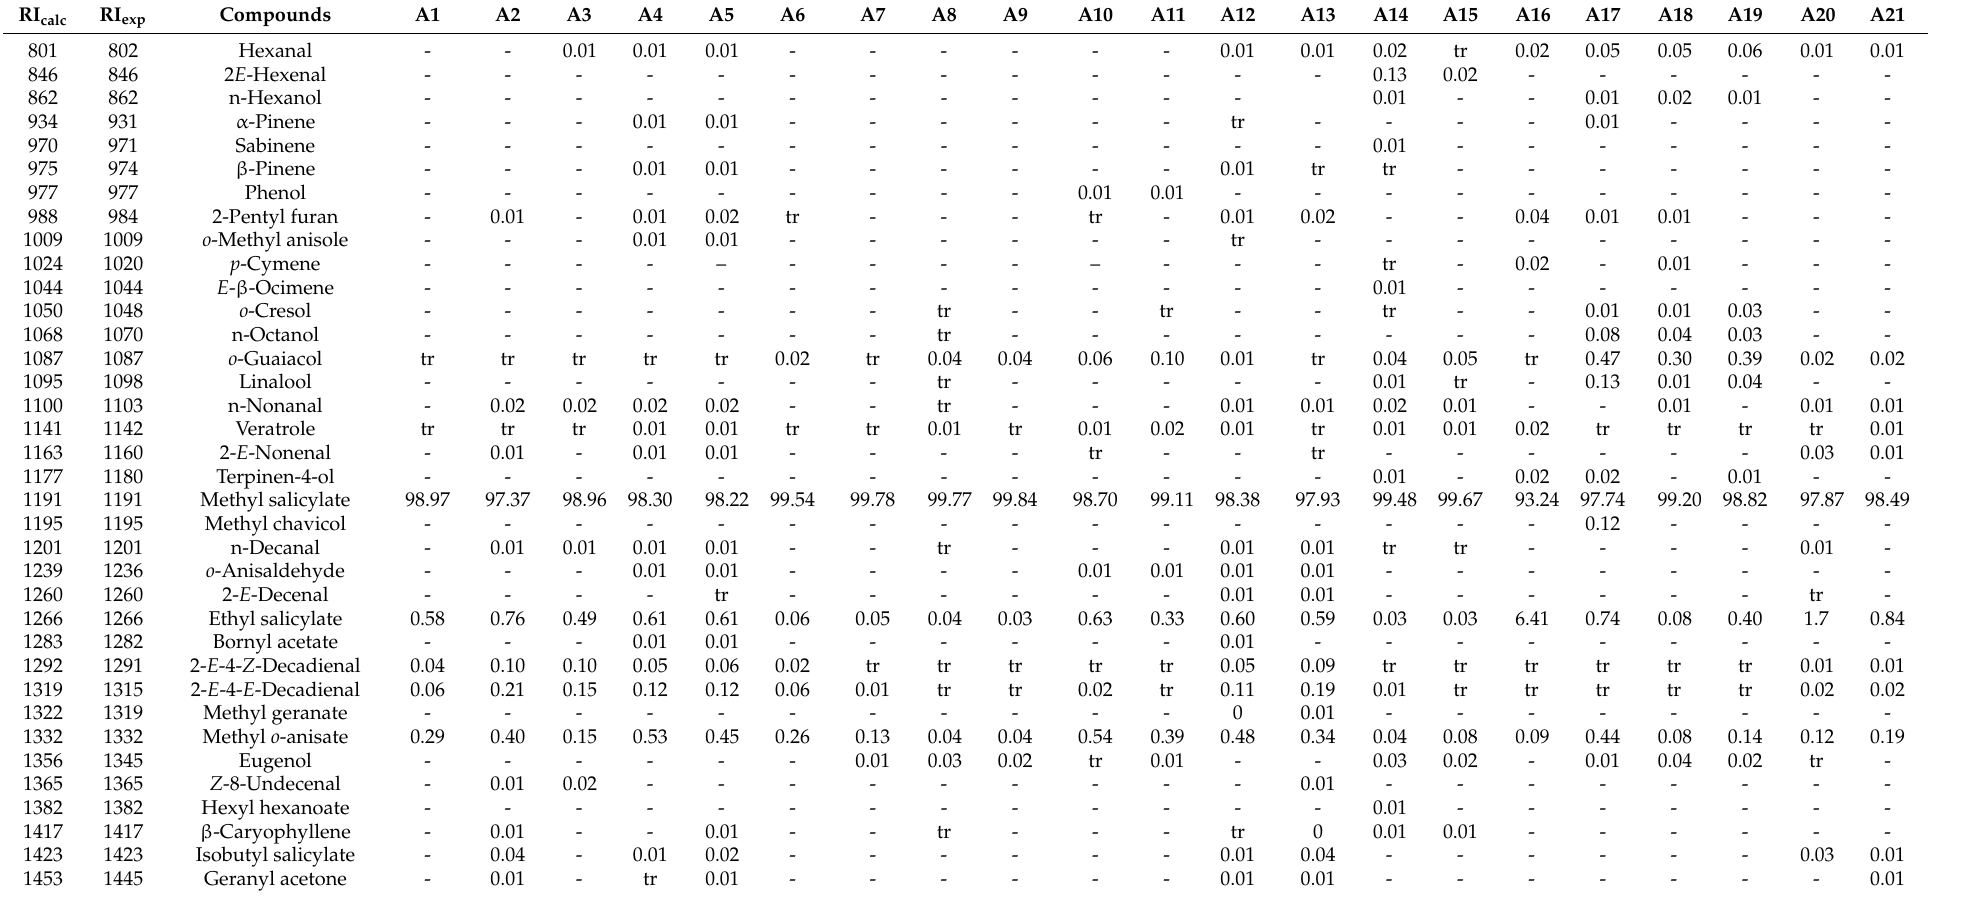
Table 2. Chemical composition of authentic (A) sweet birch EO